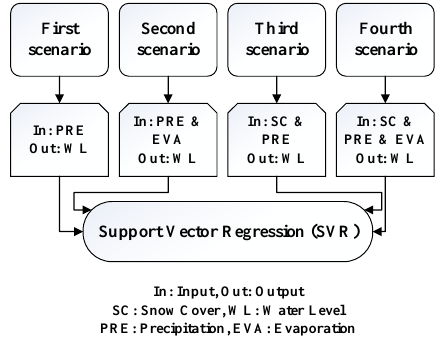
Figure 5: Flowchart of the proposed